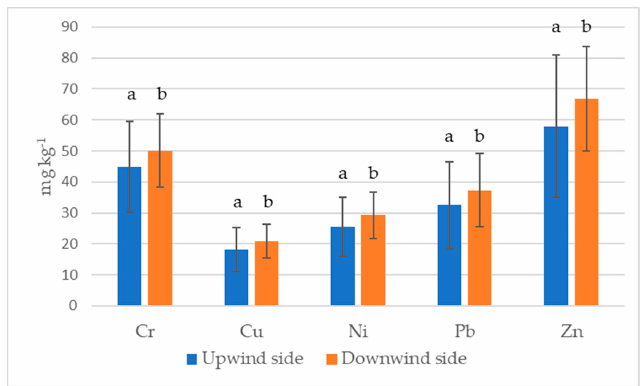
Figure 4. Comparison of mean element concentration against wind direction. Bars marked with the same letters within one element indicate no difference according to U Mann − Whitney test ( n = 36).